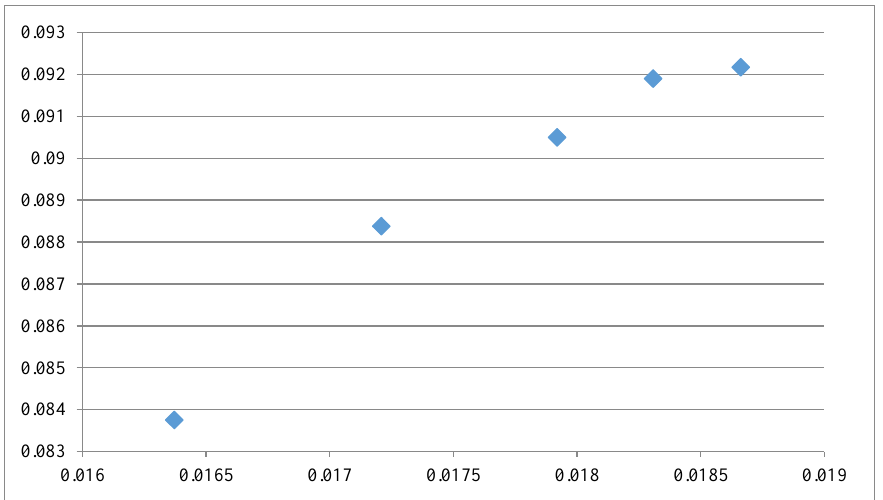
Figure 8. Efficient frontier with constraint of selecting 16 stocks from 20 ones for LPM model with Rnec=